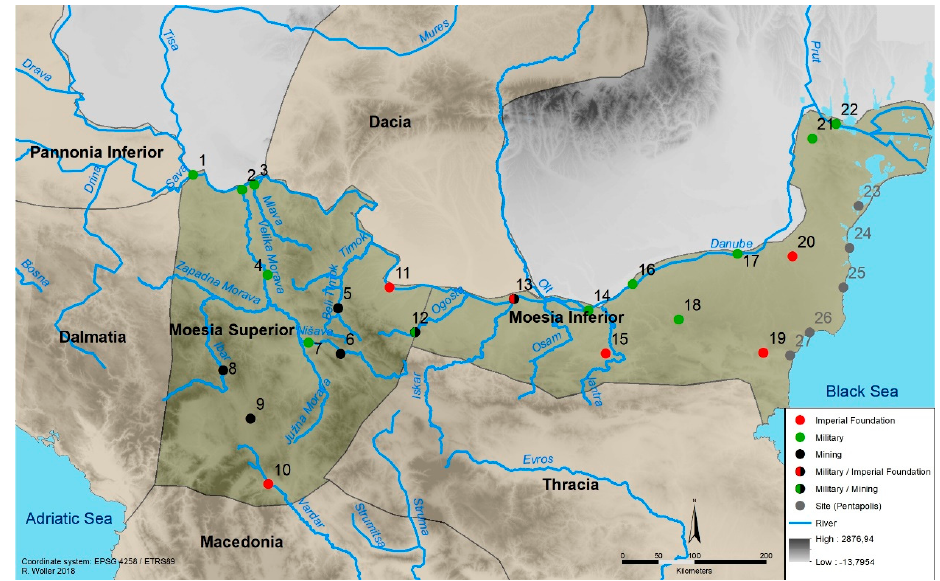
Figure 1. Overview of urban settlements in Moesia (Superior and Inferior), including the Pentapolis at the western Black Sea littoral. © Raffaela Woller, Lina Diers. Table 1. Classification of Moesian urban settlements by significant local and/or regional development factors (military presence, imperial agency, mining) instead of administrative status. Administrative status of respective settlements for comparison is indicated in parentheses.